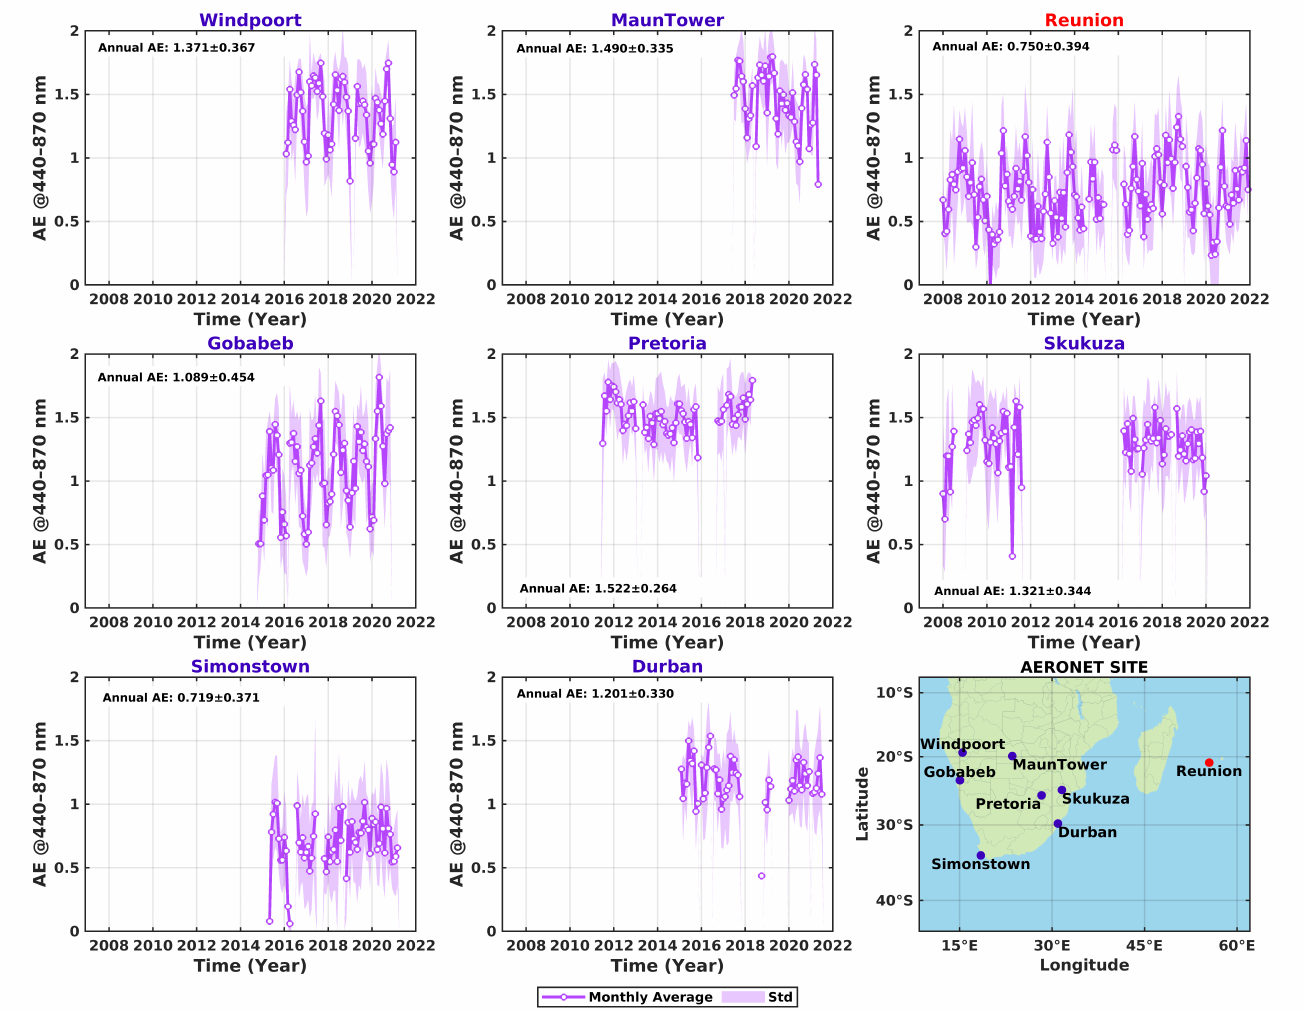
Figure 4. Time series of AE at 440–870 nm over the eight sun photometer sites. Solid lines (shaded area) show monthly average (±1 standard deviation). Annual AE values are provided during the study period. The bottom right panel represents the location of sun photometer